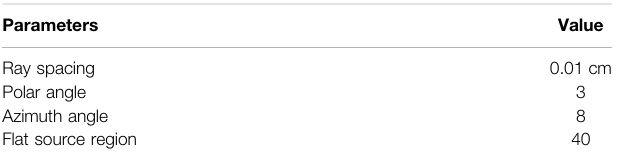
TABLE 1 | Calculation parameters of this